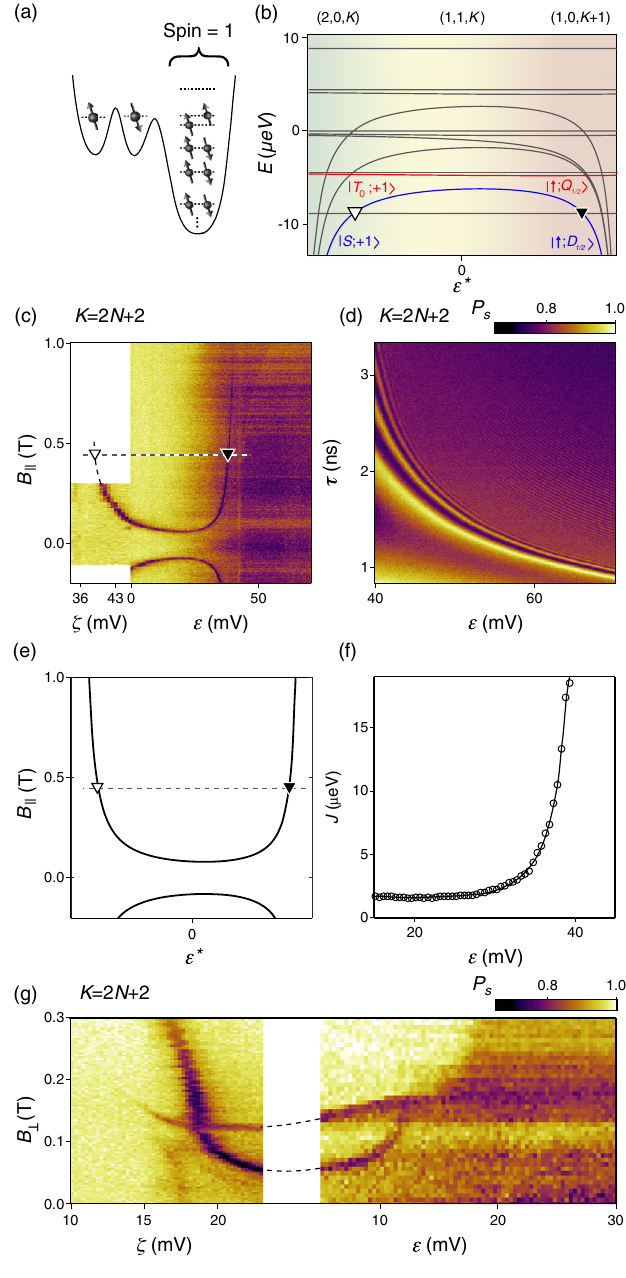
FIG. 13. (a) Schematic of the even-occupied multielectron quantum dot with spin-1 ground state, tunnel coupled to the two- electron double quantum dot. (b) The inferred energy diagram at the transition between ð 2 ; 0 ; 2 N þ 2 Þ , ð 1 ; 1 ; 2 N þ 2 Þ , and ð 1 ; 0 ; 2 N þ 3 Þ electronic configurations, for a finite magnetic field. The markers indicate the crossings revealed by leakage spectroscopy presented in (c). (d) Time-resolved measurement of exchange oscillations between the 2 N þ 2 occupied spin- 1 = 2 multielectron quantum dot and the middle electron. (e) Calcu- lated leakage spectrum, extracted from the calculated energy diagram as described in Sec. IV. (f) Dependence of the exchange energy extracted from the leakage spectroscopy in (c). (g) Leak- age spectroscopy in a magnetic field applied perpendicular to the 2DEG plane, B ⊥